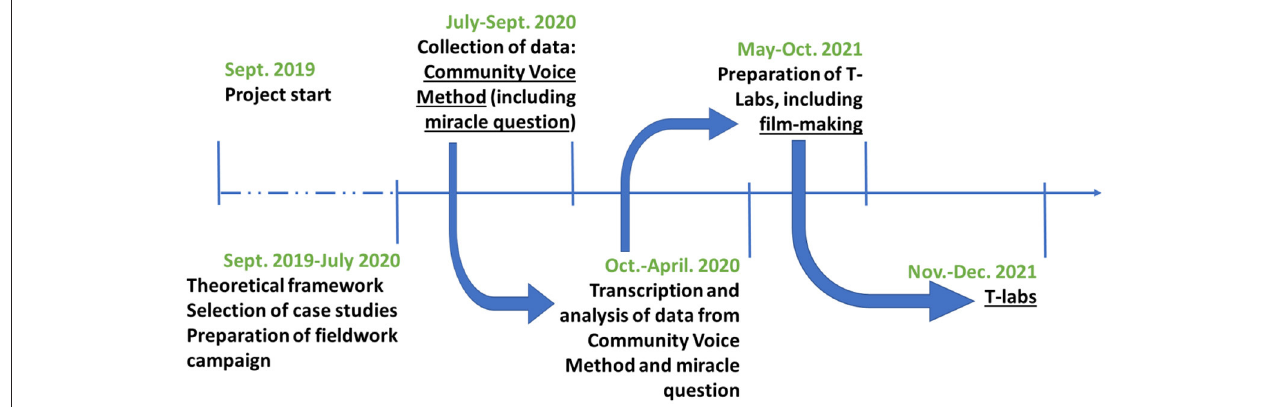
FIGURE 2 | General research approach and